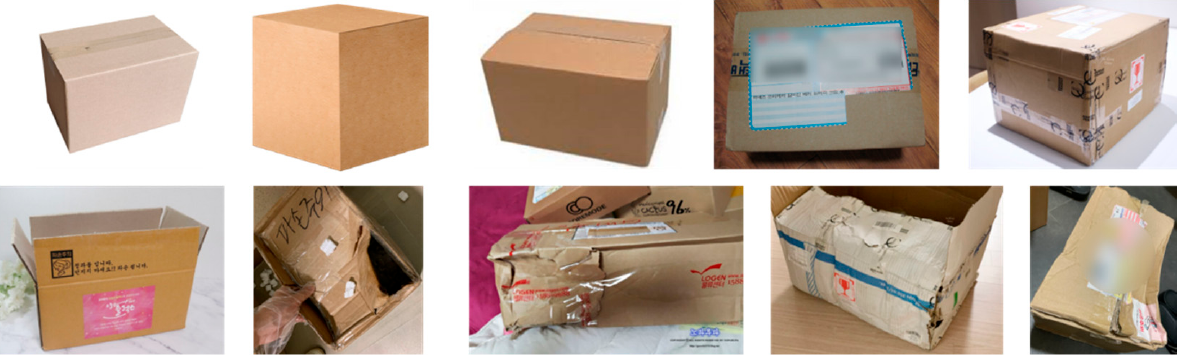
Table 3. Experimental environment.